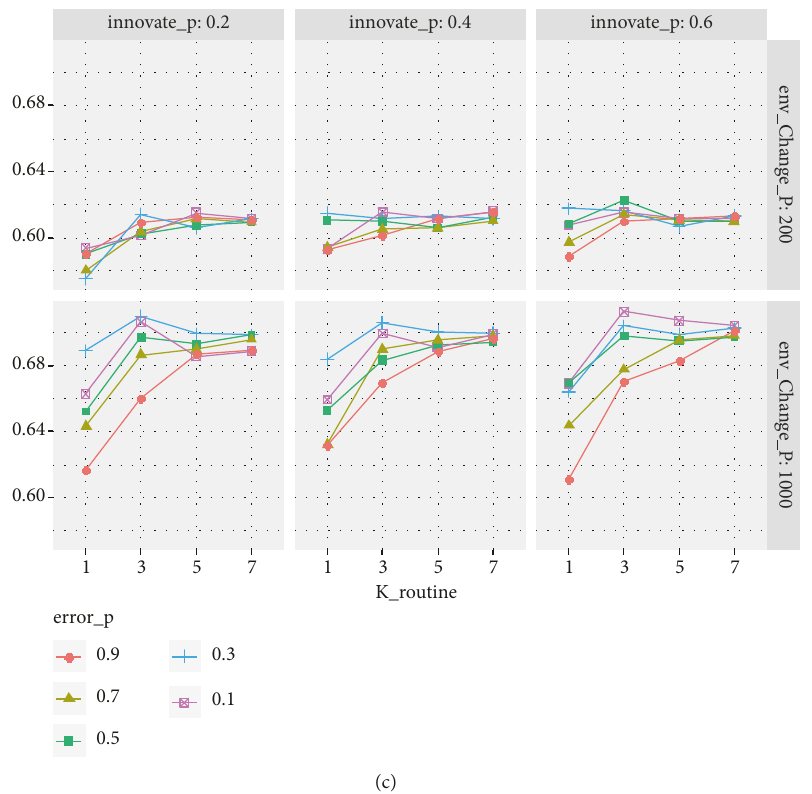
Figure 9: Simulation results with internally and externally coupled uncertainties (Scenario IV: random P = 0.5 and unit AC = 2): (a) replicate num values; (b) innovate num values; (c) avg Fitness